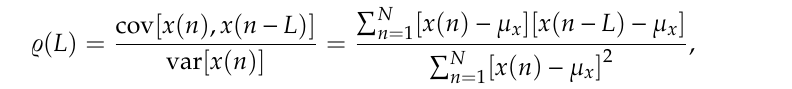
Figure 17. Electricity demand autocorrelation: ( a ) Values corresponding to the first IMF; ( b ) dominant frequencies for each IMF and their comparison to DFT and MHT spectral centroids. In this subsection, three methods to obtain the featuring frequency of every IMF have been presented. The results are summarized and compared in Figure 17b. It can be seen that all of them offer very similar results, except the DFT-obtained centroids. A more detailed analysis shows that